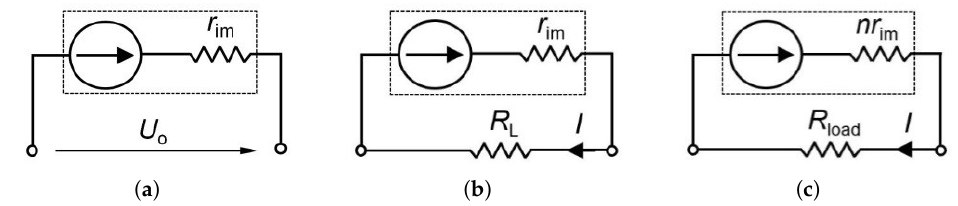
Figure 14. Equivalent electrical circuits of the TEG; ( a ) open circuit voltage; ( b ) closed circuit voltage (with load resistance of single TEG); ( c ) closed circuit voltage (with load resistance of n